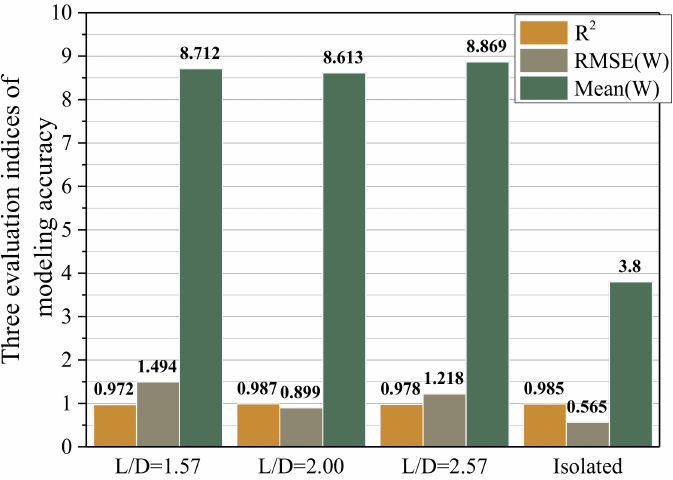
Figure 5. Three evaluation measures of modeling